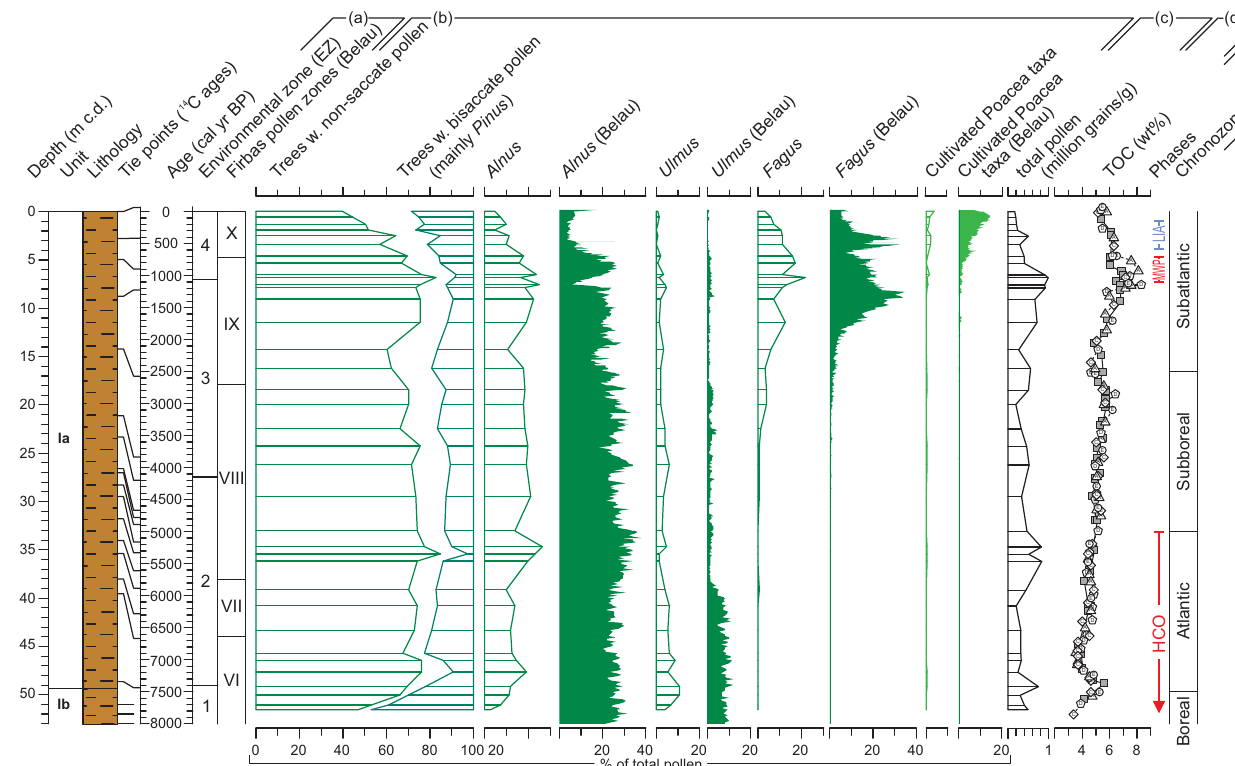
Figure 2. Comparison of the pollen record from IODP Site M0059 with the varved pollen record of Lake Belau (northern Germany; Dörfler et al., 2012). Sedimentological units, lithology (Andrén et al., 2015a), and position of 14 C ages (Van Helmond et al., 2017) plotted vs. depth and plotted vs. age (extrapolated below ∼ 48.64 mc.d.). (a) Environmental zones (EZs; IODP Site M0059) and Firbas pollen zones (Lake Belau). (b) Selected pollen taxa (with horizontal bars: IODP Site M0059; filled: Lake Belau). (c) Total organic carbon (TOC; white: shipboard data; triangles: Hole A; rhombi: Hole C; pentagons: Hole D; circles: Hole E; grey squares: onshore data) for IODP Site M0059. (d) Climate phases and